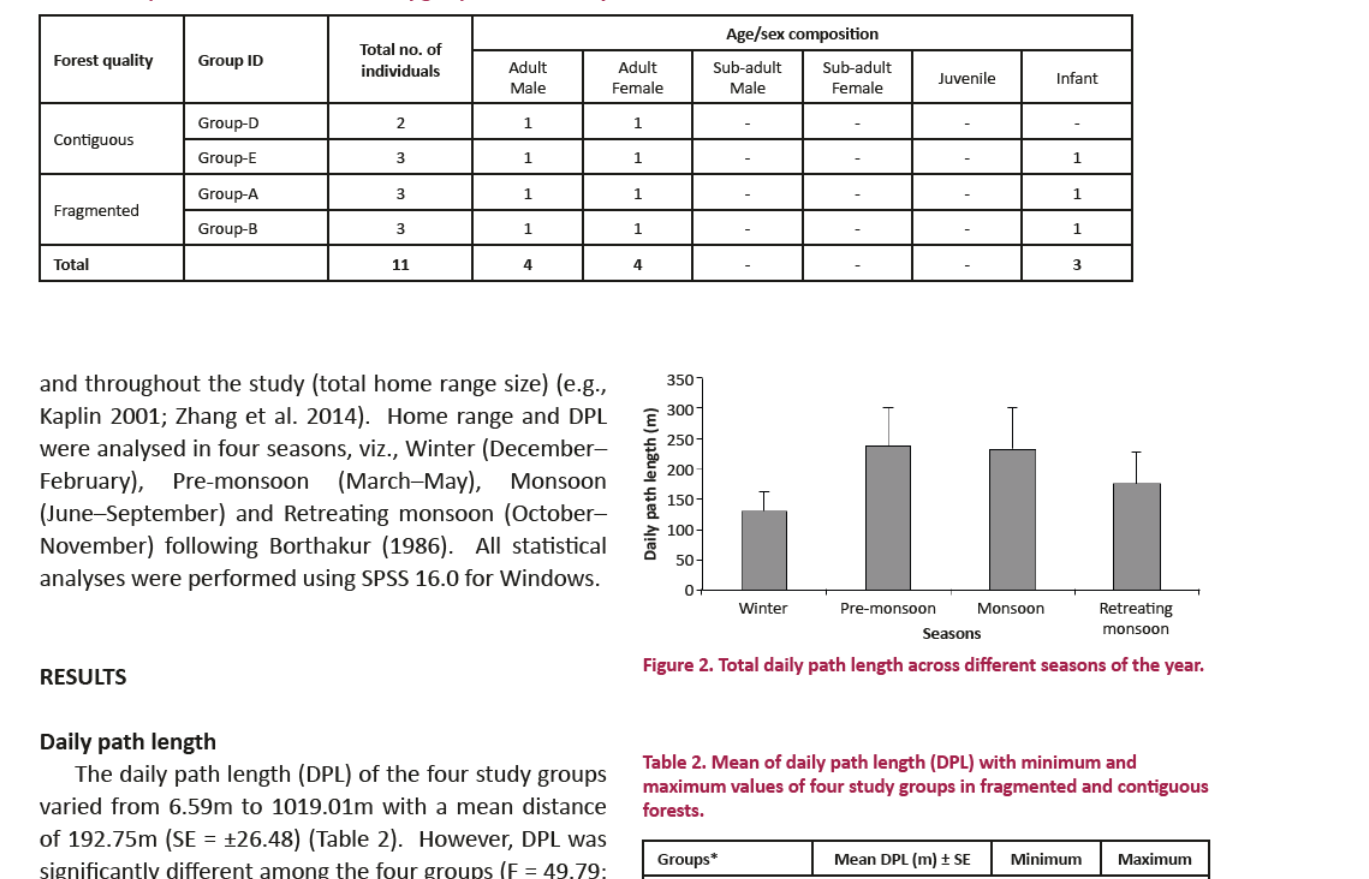
Table 1. Group sttructture off tthe selectted sttudy groups off H. leuconedys.